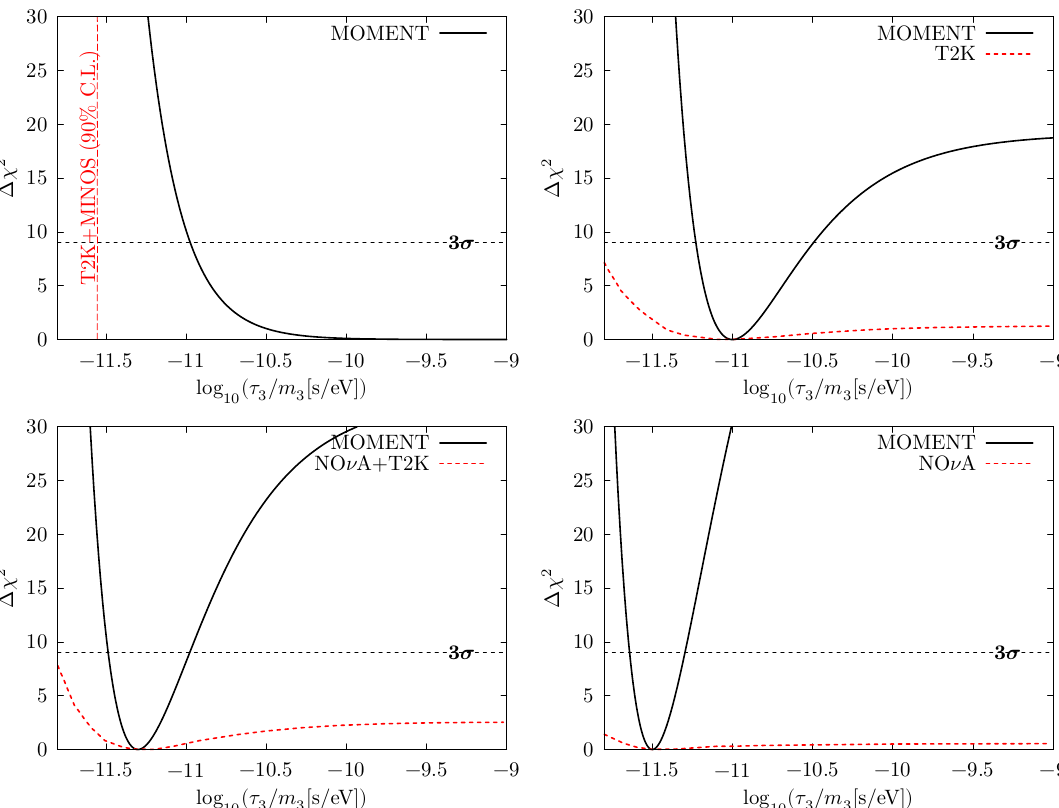
Figure 6 . The (cid:1) (cid:31) 2 = (cid:31) 2 (cid:0) (cid:31) 2 as a function of the test value of (cid:28) 3 =m 3 where the inputed min true value of (cid:28) 3 =m 3 is assumed to be 1 (upper left), 10 (cid:0) 11 (upper right), 5 : 01 (cid:2) 10 (cid:0) 12 (lower left) and 3 : 16 (cid:2) 10 (cid:0) 12 s = eV. The black solid curve is for MOMENT. The short-dashed curves, taken from ref. [32], correspond to current experiments: the upper-left and upper-right panels are the combination of T2K and MINOS and T2K, respectively, while the lower two panel are the combination of T2K and NOvA (left) and NOvA